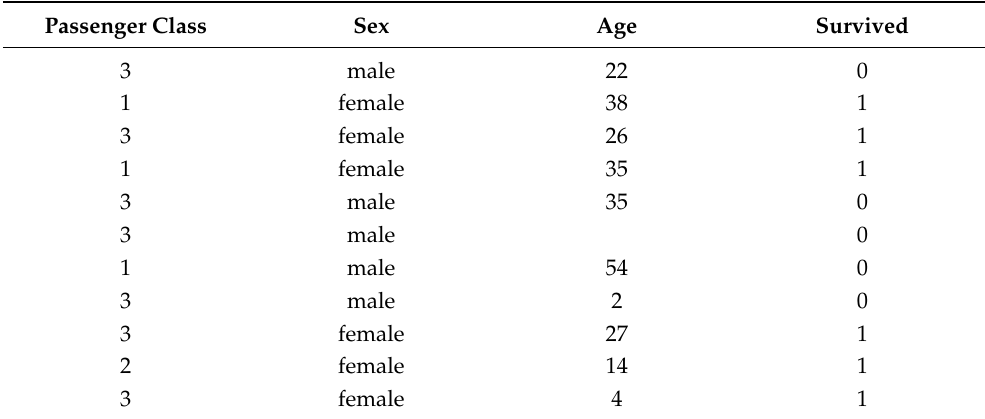
Table 1. Summary of baseline dataset utilized from [33].